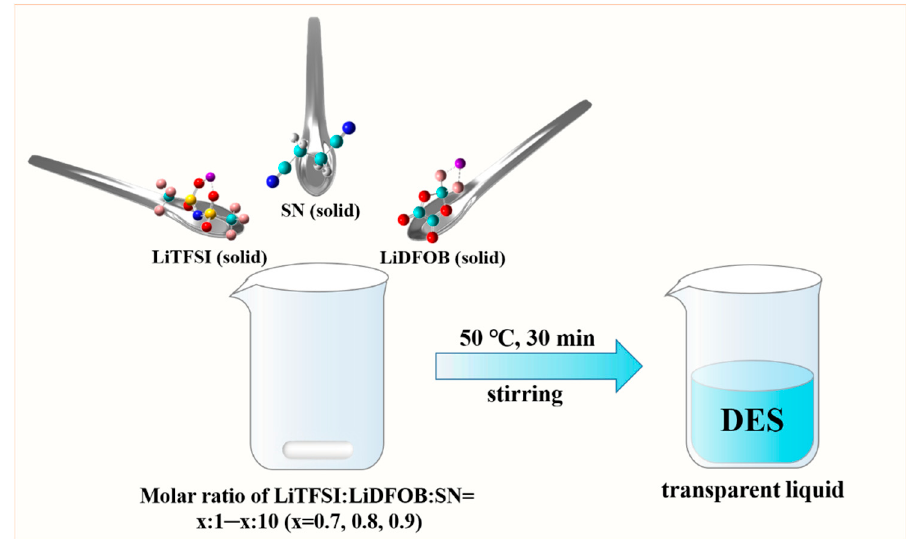
Figure 1. The preparation process of the DES electrolyte.